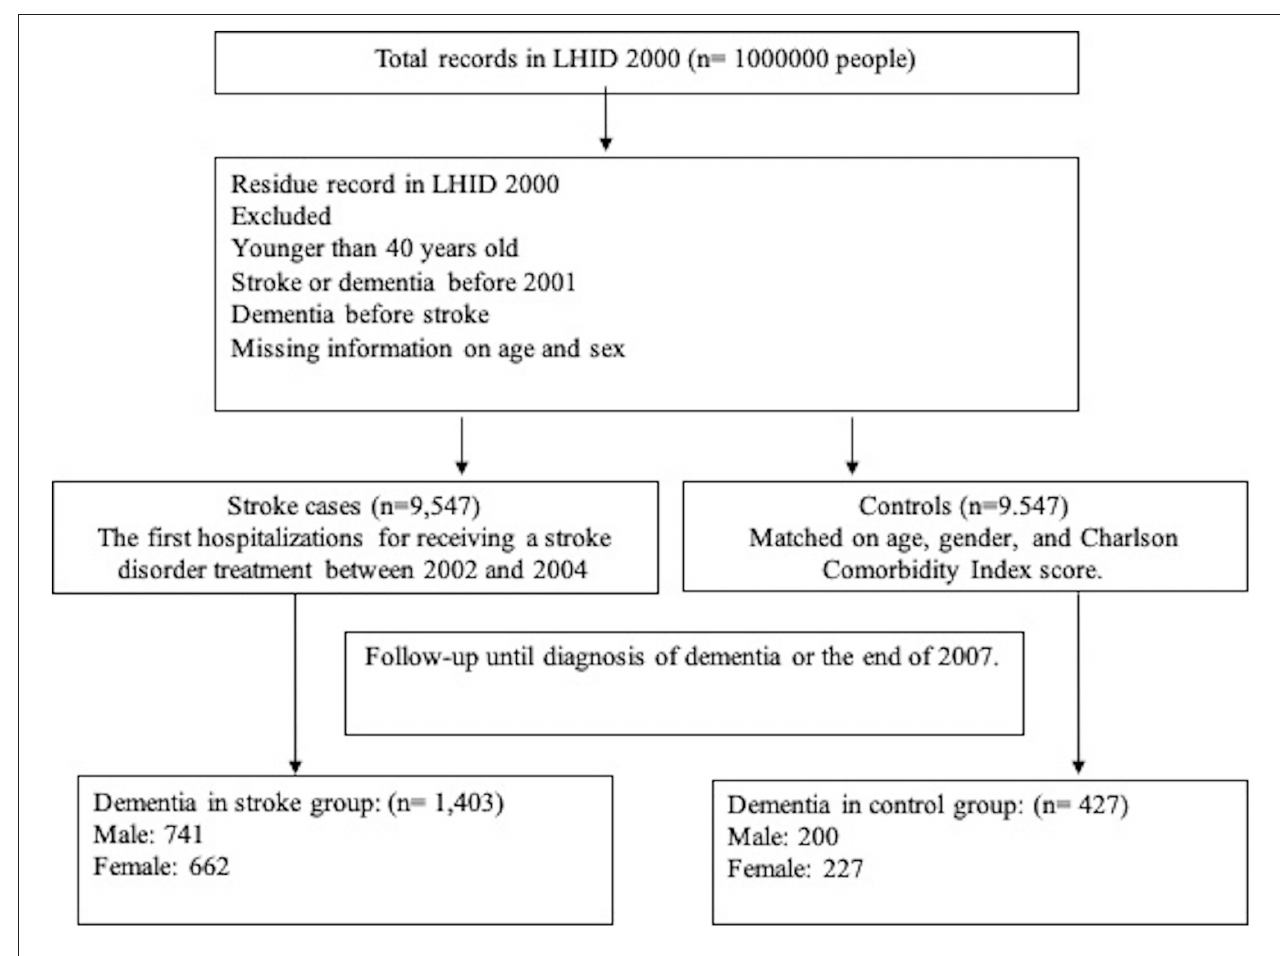
FIGURE 1 | Flow chart of the study population.